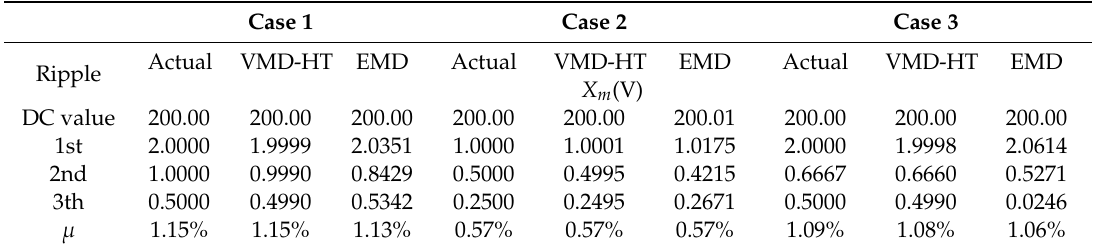
Table 3. Ripple components of direct-current (DC) voltage without noise.